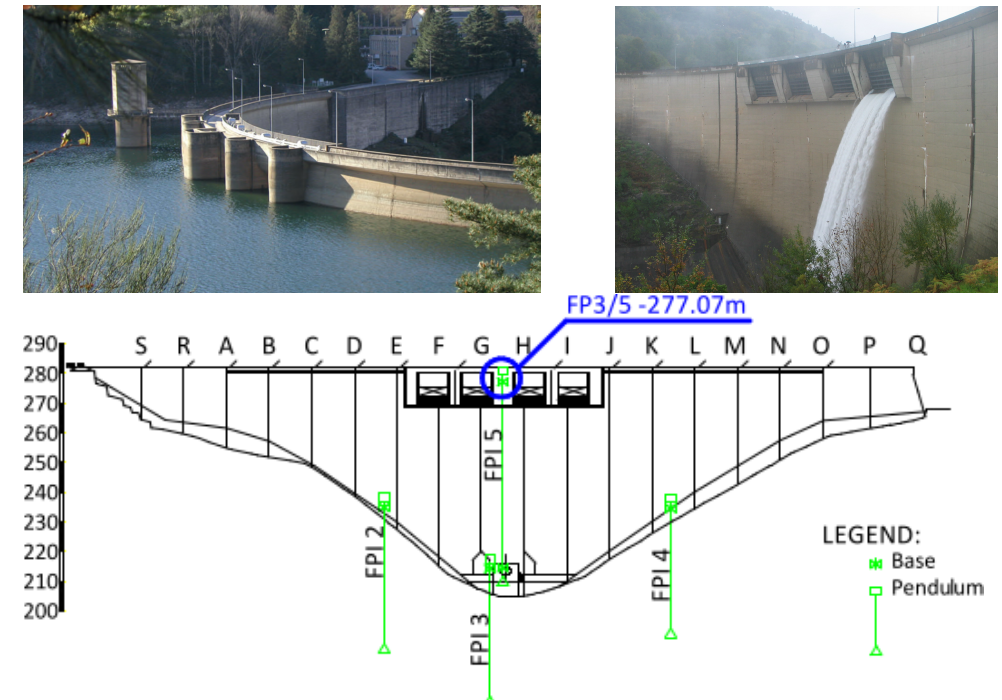
Figure 6. Salamonde dam: Upstream and downstream dam faces and pendulum